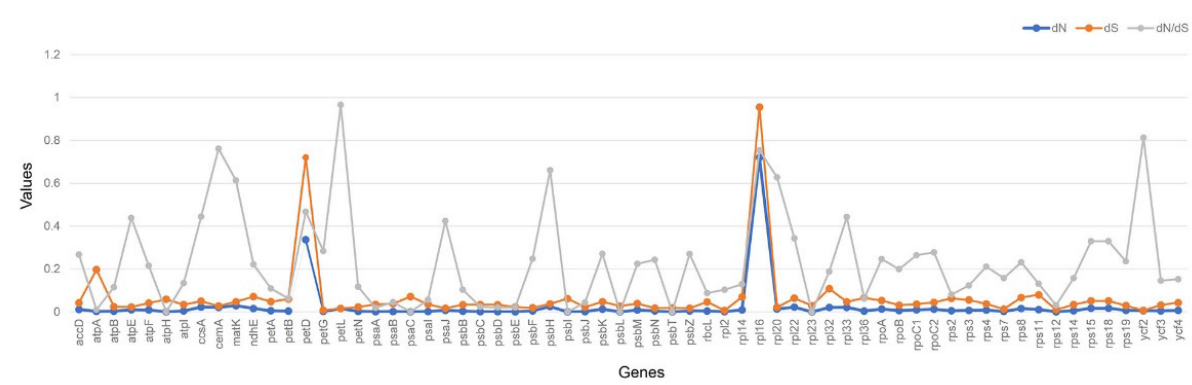
Fig. 6: The non-synonymous (dN), synonymous (dS) and dN/dS ratio values of 64 protein-coding genes of chloroplast genome among the Gentiana